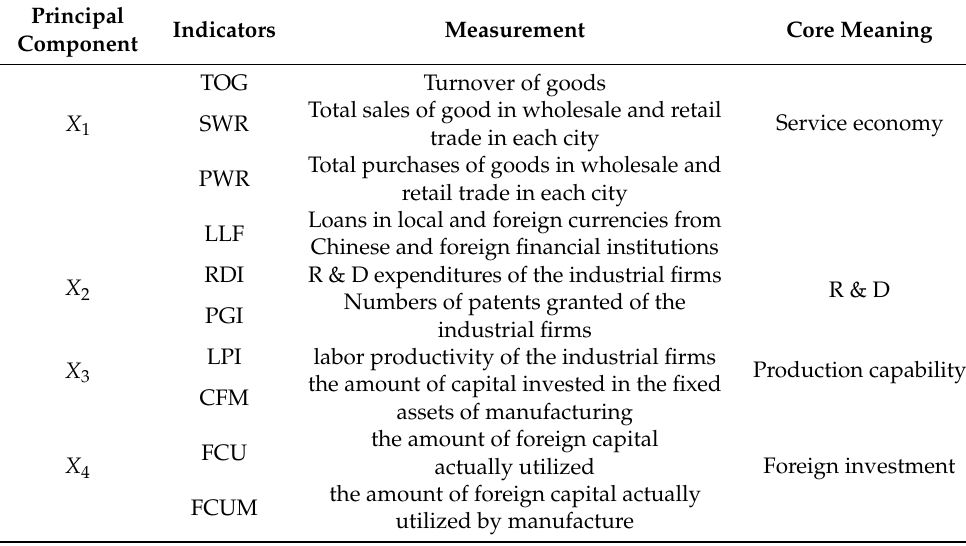
Table 1. The dominant factors of principal components of driving